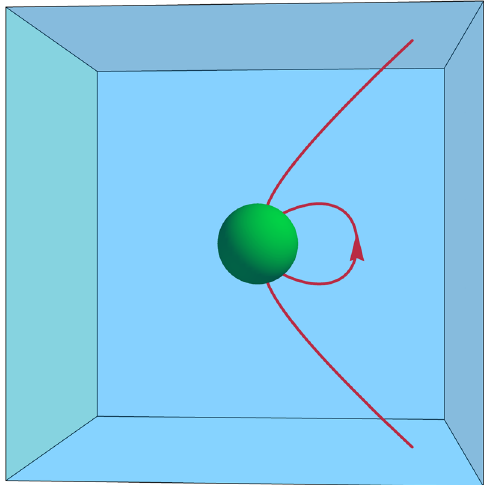
Fig. 4 The Onsager cavity acts as an inner boundary of the system. The harmonic phase is de fi ned by polarisation or magnetisation fi eld lines (red) that terminate on either the inner (green) or outer system boundaries but not within the system volume